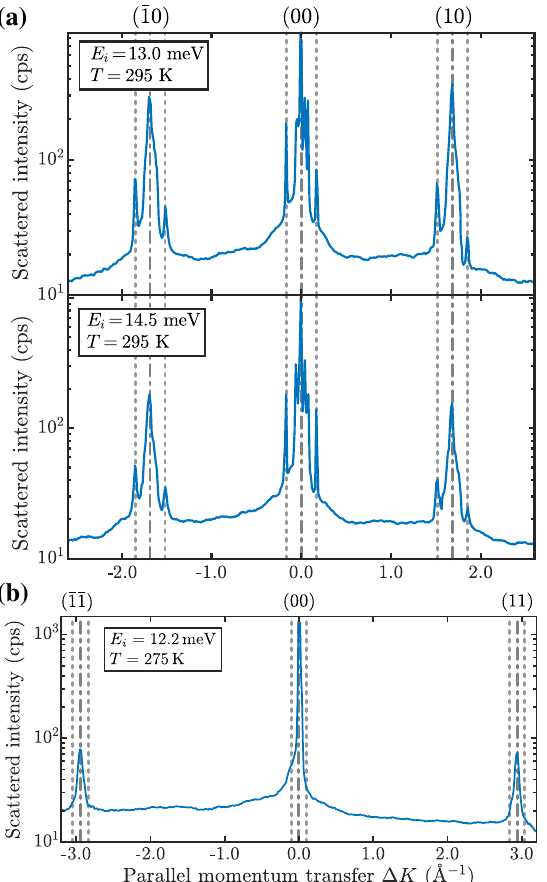
Figure 2. The CDW periodicity becomes evident in diffraction scans (logarithmic scale) of Bi 2 Te 2 Se(111). ( a ) Scans along Γ M taken at room temperature show satellite peaks (illustrated by the grey dashed vertical lines) next to the specular and first-order diffraction peaks (grey dash- dotted vertical lines). ( b ) Same for the Γ K direction; in this direction no evident satellite peaks are observed close to the diffraction